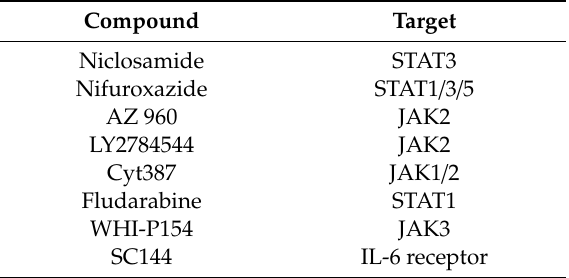
Table 2. JAK-STAT3 inhibitors identified after two-round of